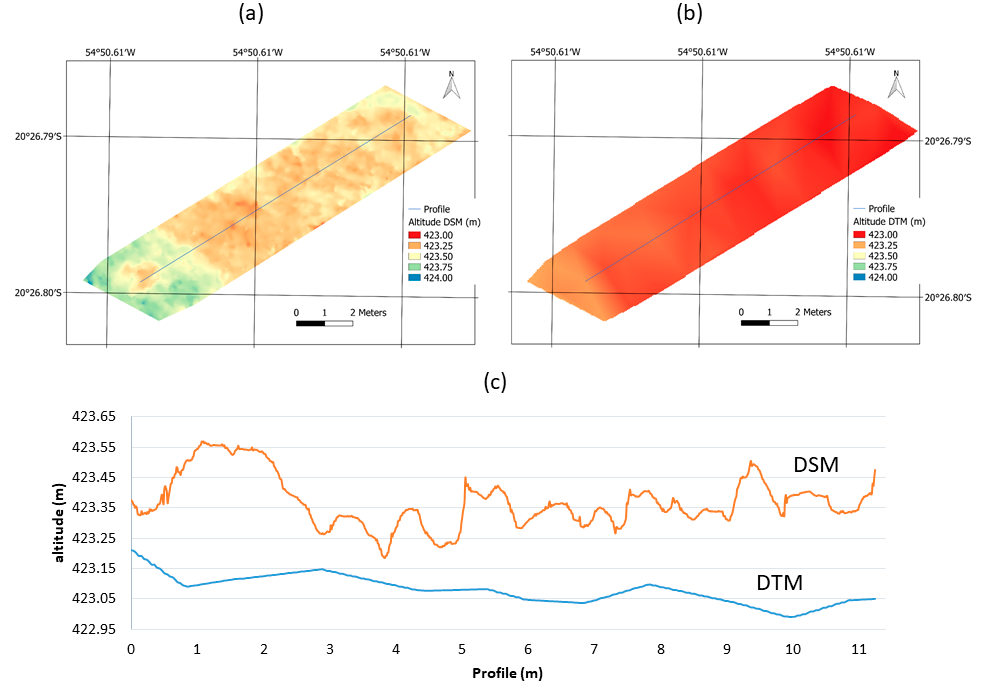
Figure 3. Generated models of the study area. ( a ) Digital surface model (DSM); ( b ) DTM generated using a Global Navigation Satellite System (GNSS) RTK receiver; and ( c ) elevation